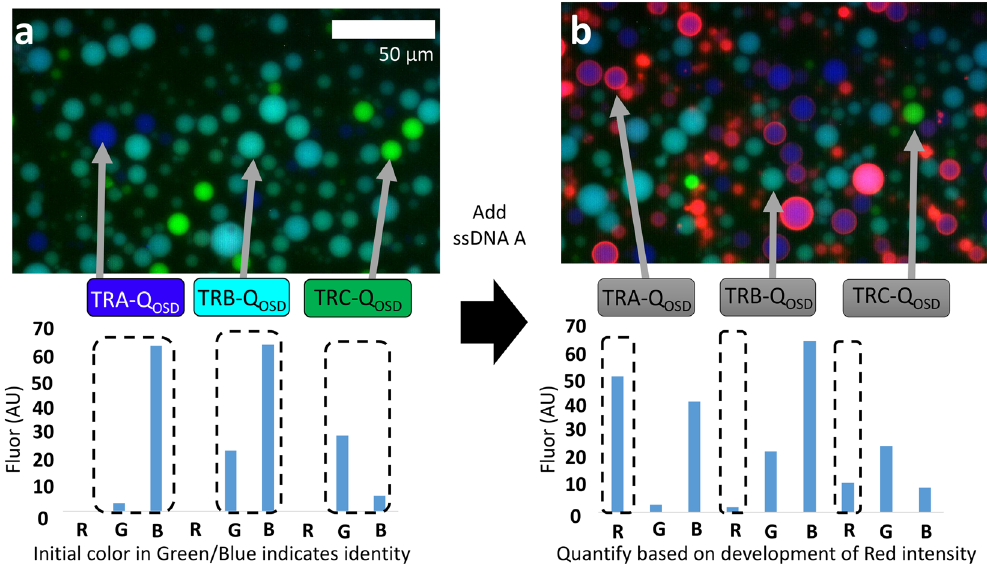
Figure 4. Multiplex particles using blue and green fluorescence. ( a ) Fluorescence micrograph and bar graph show the microparticles and corresponding fluorescence intensities in the red, green and blue channels before addition of ssDNA A. ( b ) Fluorescence micrograph and bar graph show resulting fluorescence intensities of the microparticles after addition of ssDNA